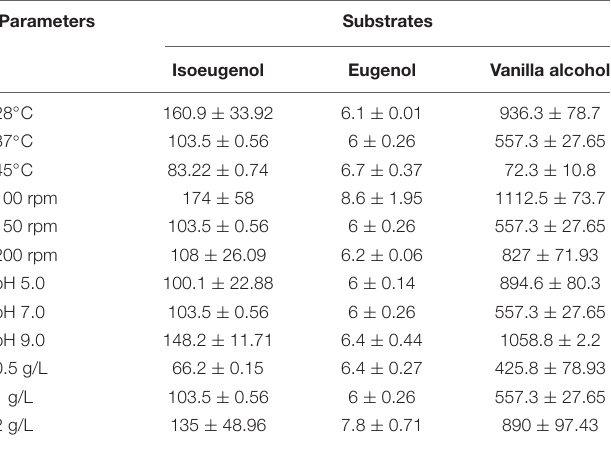
TABLE 1 | Yield of vanillin (mg/L) transformed by Bacillus pumilus ZB1 with the different guaiacyl lignin monomers as the substrate.